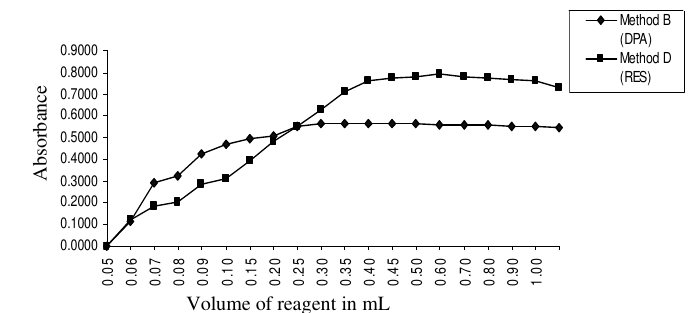
Figure 3. Effect of diphenylamine (DPA) and resorcinol (RES).